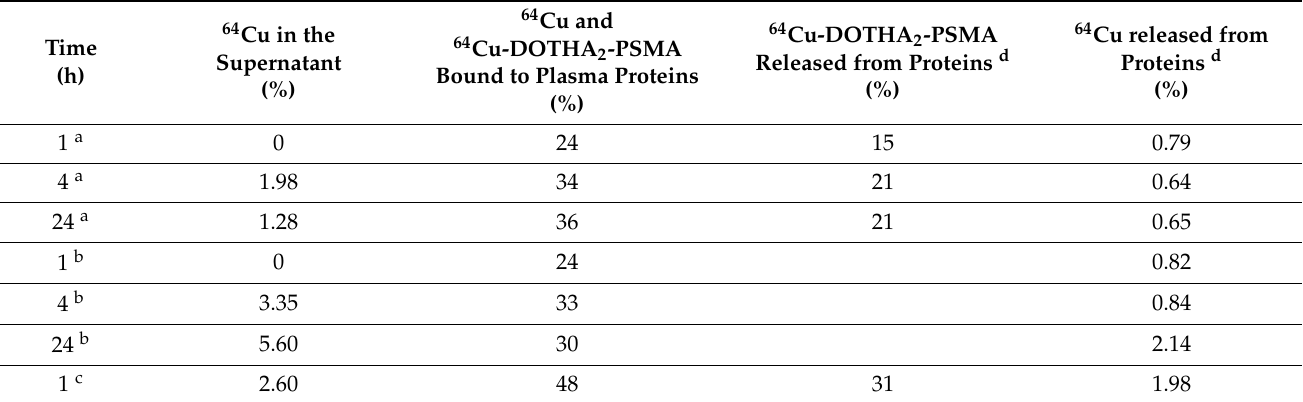
Table 1. 64 Cu-DOTHA 2 -PSMA stability profile.